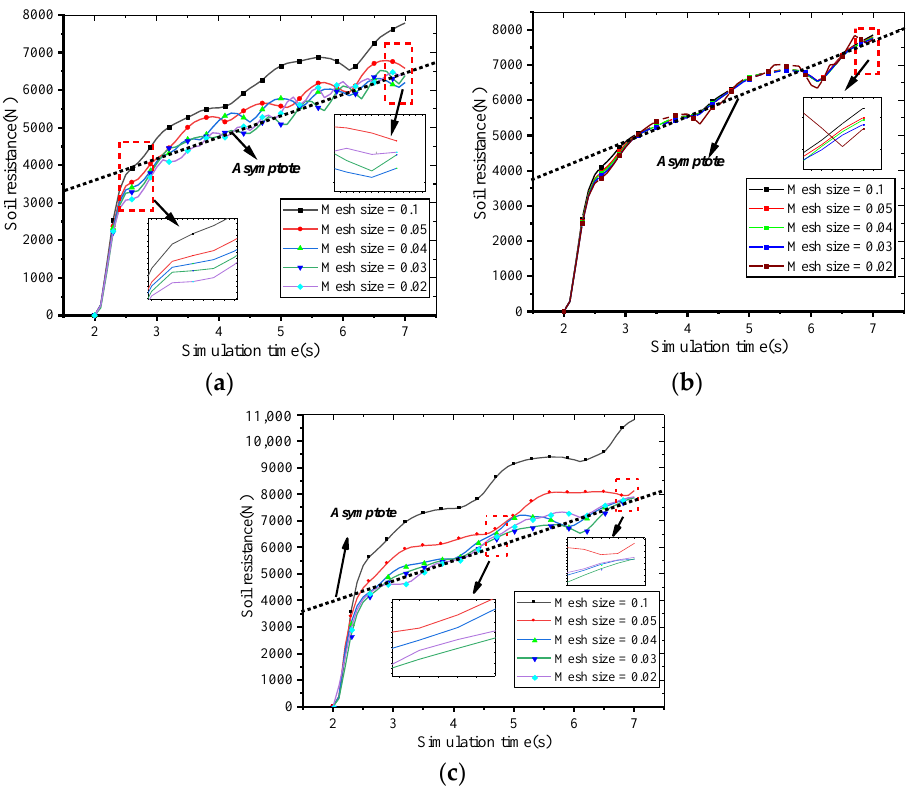
Figure 9. Sensitivity analysis results of each mesh seed. ( a ) Zone-1, ( b ) Zone-2, ( c ) Zone-3. Table 8. The mesh seed value.